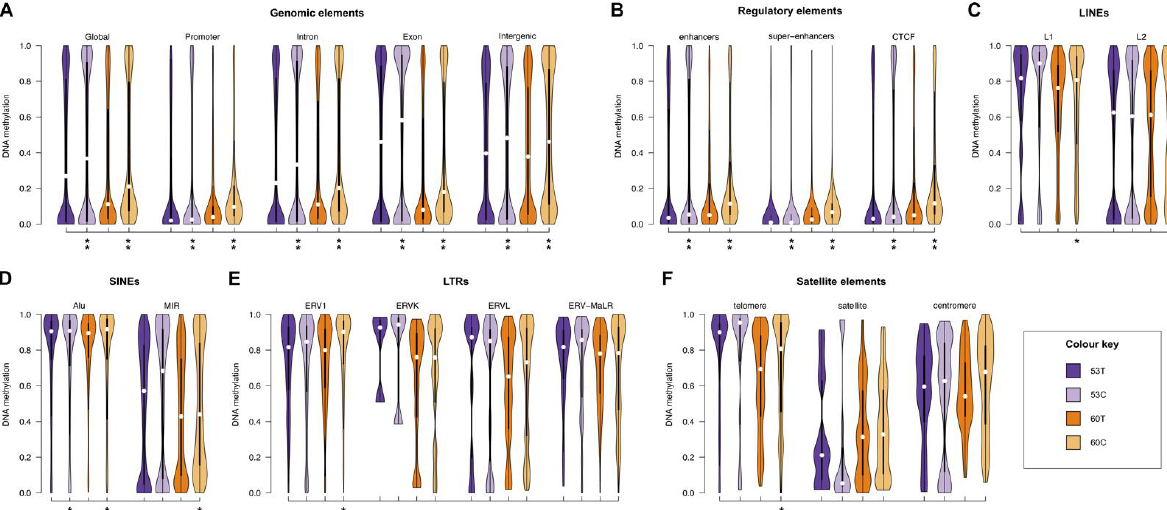
Figure 2. Element-wise methylation profiles in melanoma tissues and derived cell lines. ( A – F ) Equal area violin plots of 53T, 53C (purple), 60T and 60C (orange) show the distribution of methylation in different genomic elements. ( A ) Gene promoters ( − 2 kb to +1 kb from the TSS), introns, exons and intergenic elements (>2 kb upstream from the nearest TSS). ( B ) Regulatory elements: enhancers, super-enhancers and CTCF binding sites ( C ) LINEs: L1 and L2. ( D ) SINEs: Alu and MIR. ( E ) LTRs: ERV1, ERVK, ERVL and ERV-MaLR. ( F ) Satellite elements: telomere, satellite, centromere. In all cases, the y axis represents methylation level on a 0 – 1 scale. * p < 0.05, ** p < 1 10 − 10 (tissue vs. cell line, Wilcoxon rank sum test).